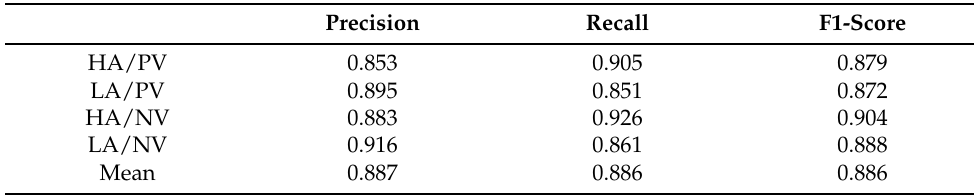
Table 4. Per class performance, Ensemble Bagged Tree classifier.